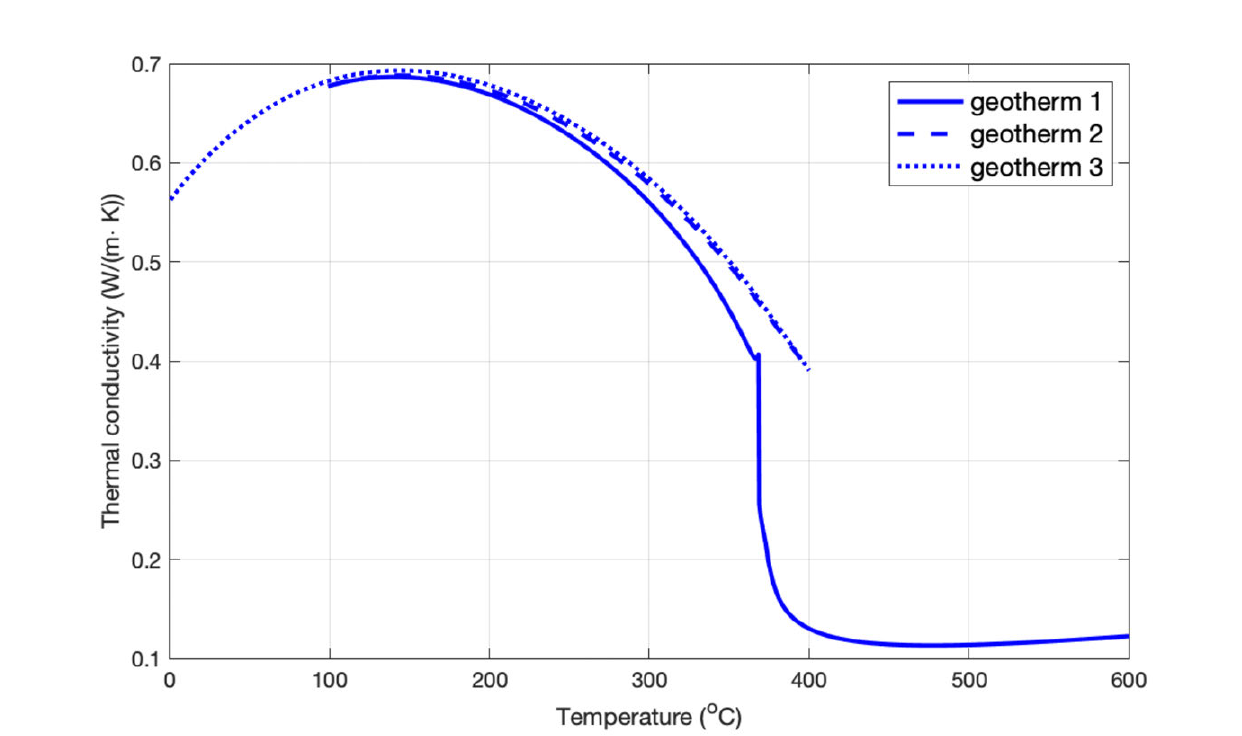
Figure D7: Thermal conductivity of water as a function of temperature for the same 3 geotherms as in Figure D5. Data from Parry et al. [2000].